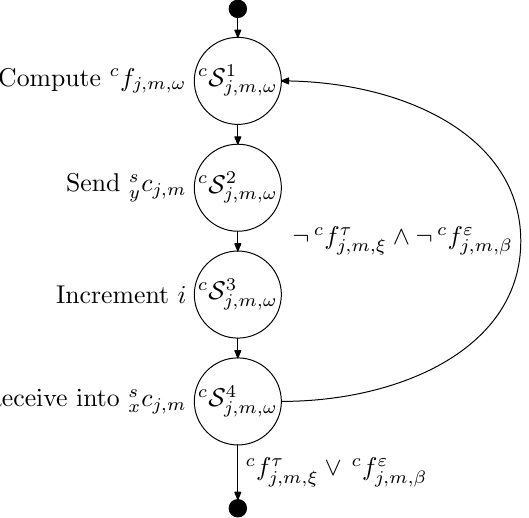
FSM c executing any behaviour. j F j